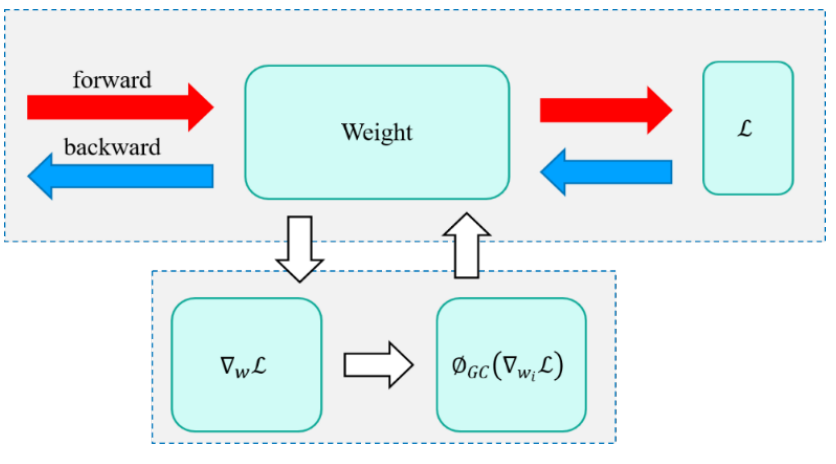
Figure 7. Sketch map for